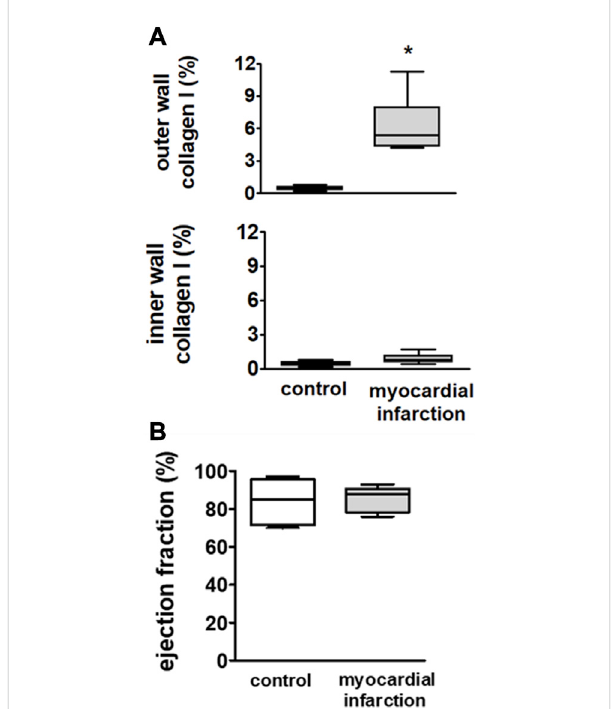
FIGURE 1 Upper panel (A) : in fi ltration of macrophagesin the outer wall and the inner wall of the left ventricle in SM controls ( n = 6) and rats with myocardialinfarction( n =9).Ratsaftermyocardialinfarctionexhibited a considerable increase of macrophages in the outer wall of the leftventricle,suggesting anon-transmuralinfarction.Lower panel (B) : echocardiographically assessed ejection fractions (EFs) were not different among rats after myocardial infarction ( n = 9) and controls ( n = 6). Hence, no overt congestive heart failure could be observed in rats after myocardial infarction. Kruskal – Wallis one-way ANOVA on ranks was used with Dunn ’ s post - hoc method. Rats were taken from the groups of rats with myocardial infarction or SHAM